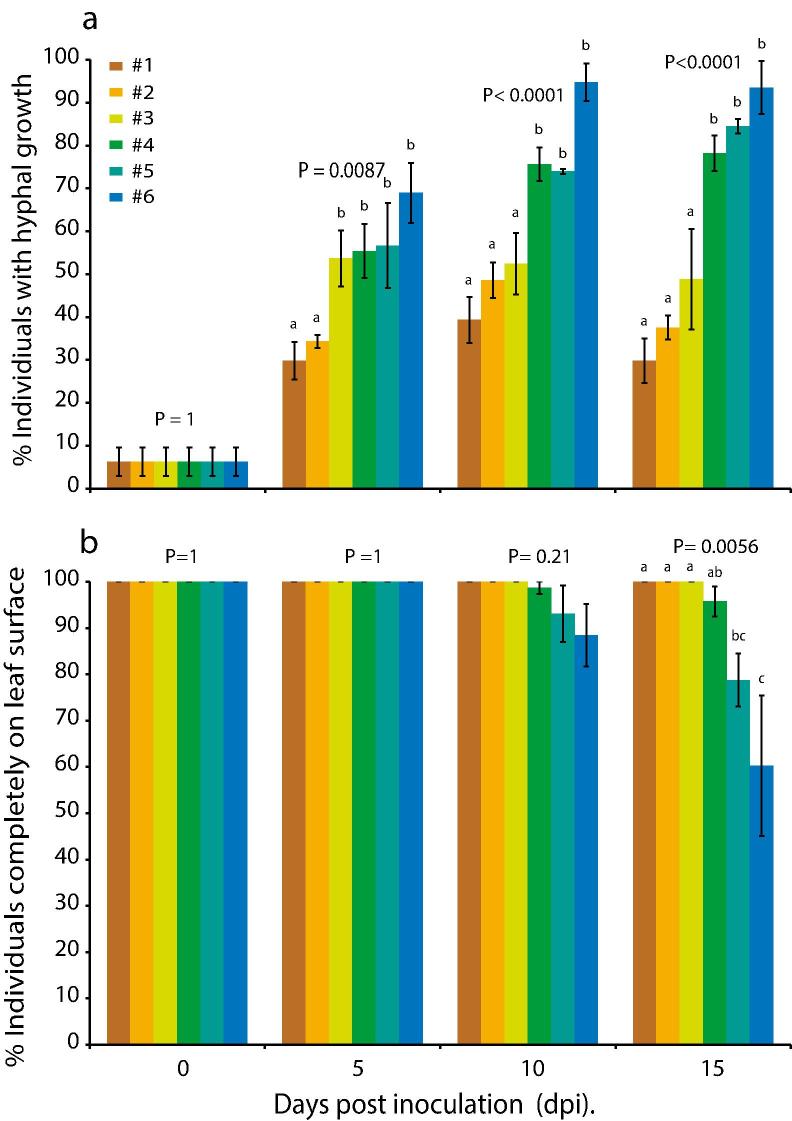
Effect of humidity upon hyphal emergence and leaf penetration over time. Galaxie wheat plants were inoculated with 106 cfu/ml suspensions of Z. tritici and maintained under six different humidity regimes (#1 – lowest, #6 – highest). Inoculated leaves were visualised at 0, 5, 10 and 15 dpi and fungi scored for hyphal growth and leaf penetration. a. Hyphal emergence, b. penetration. Data are means of three independent experiments; error bars show SE. Within each time-point, results that are not significantly different are marked with the same letter (ANOVA with Tukey’s simultaneous comparisons; P-values above graphs).